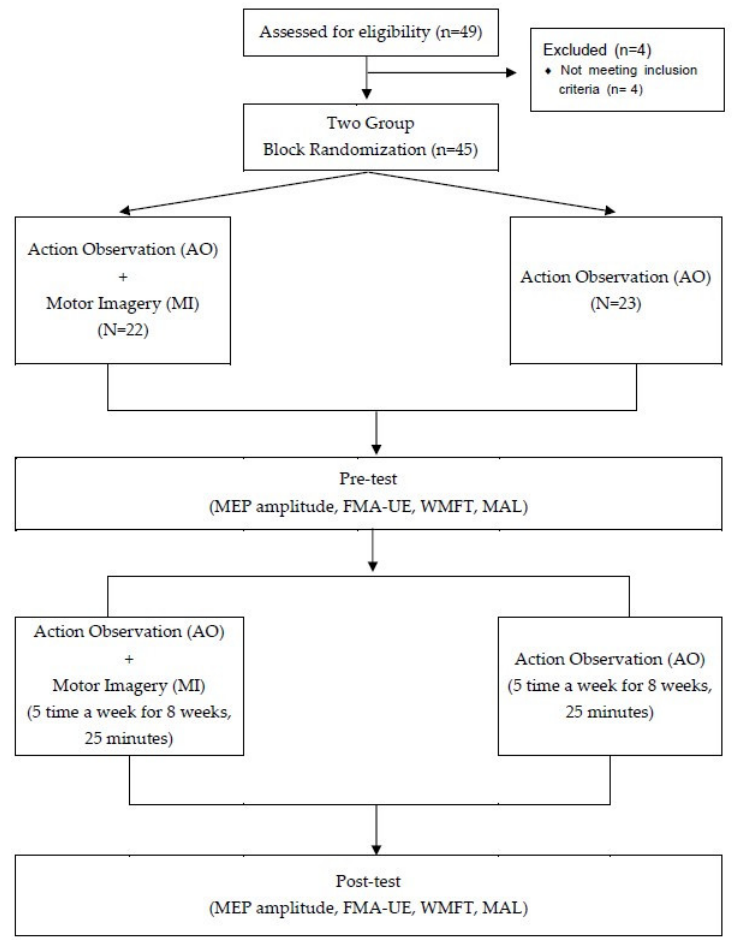
Figure 1. Flow diagram of the study.